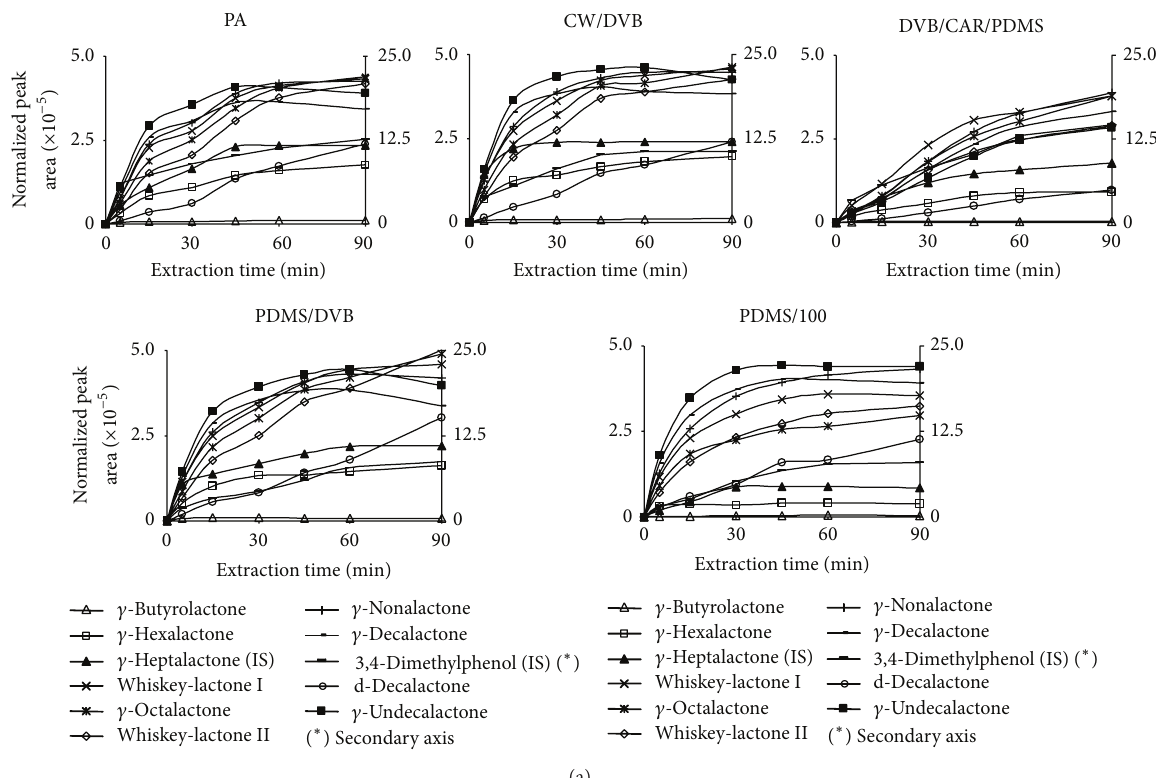
Figure 2: Extraction profiles of the different analytes versus extraction time for the different